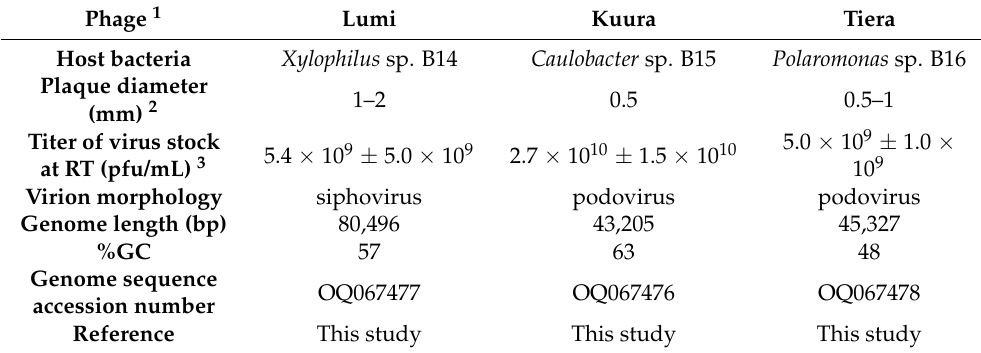
Table 2. Freshwater lake viruses isolated from under ice cover.